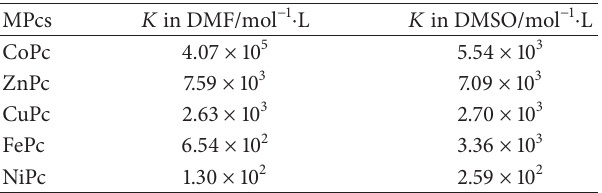
Table 1: The dimerization equilibrium constant 𝐾 of the five MPcs (30 ∘ C).